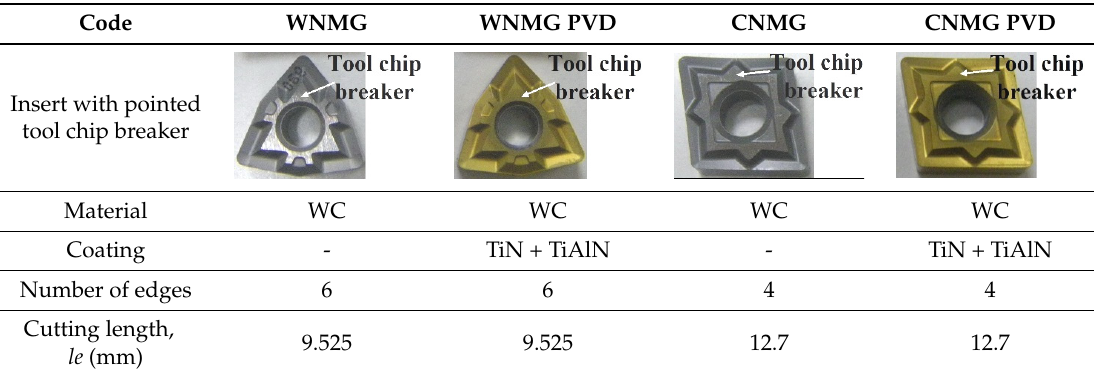
Table 2. Characteristics of the inserts.